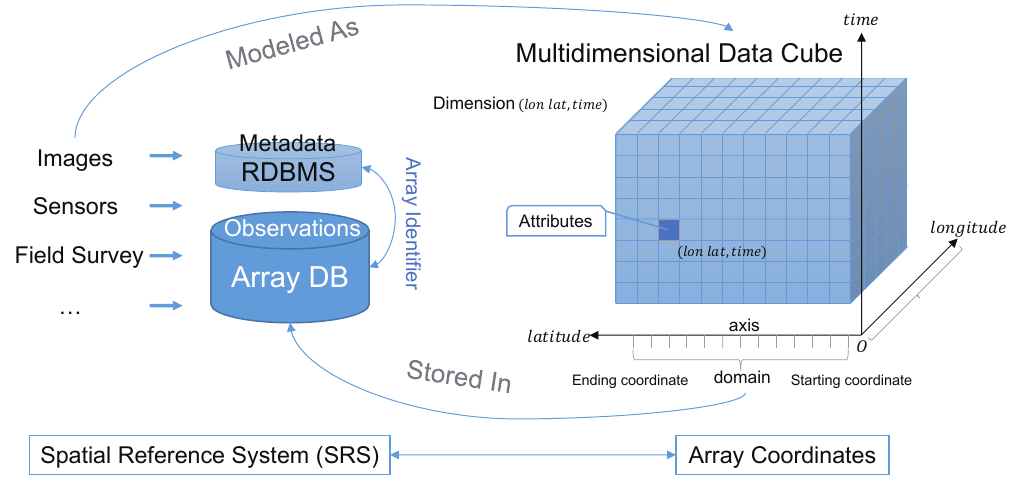
Figure 2. The array database approach for EO data